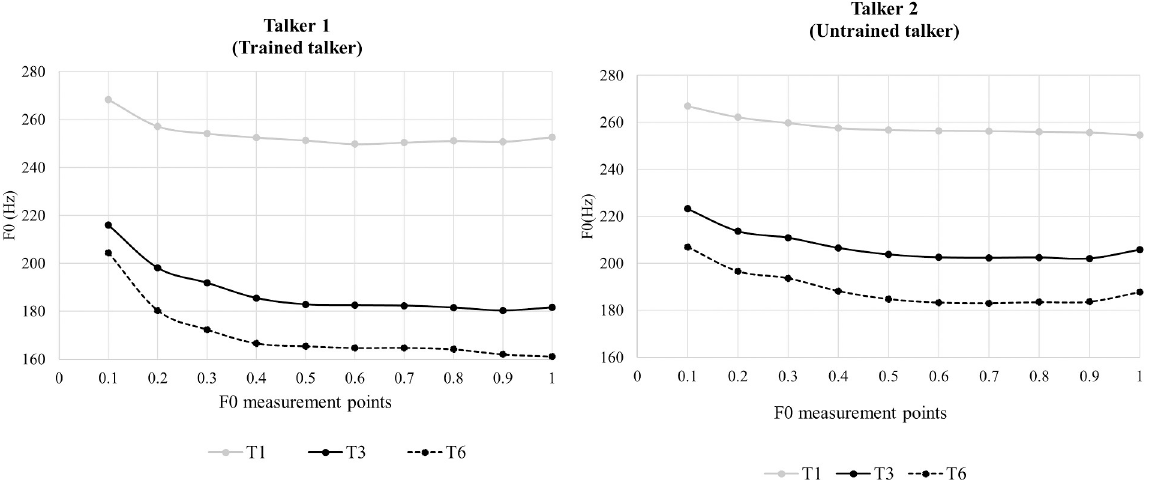
Fig 2. Tonal contours of the three Cantonese level tones. Tonal contours were measured using ten measurement points and produced by the trained female talker (left panel) whose stimuli were used in both the training and posttests as well as the untrained female talker (right panel) whose stimuli were used in the posttests